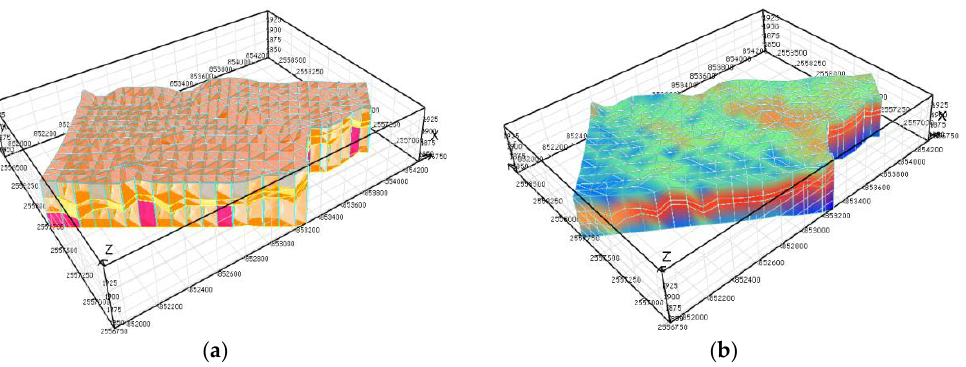
Figure 1. The triangular prism model. ( a ) Before simulating the property field; ( b ) after simulating the property field.